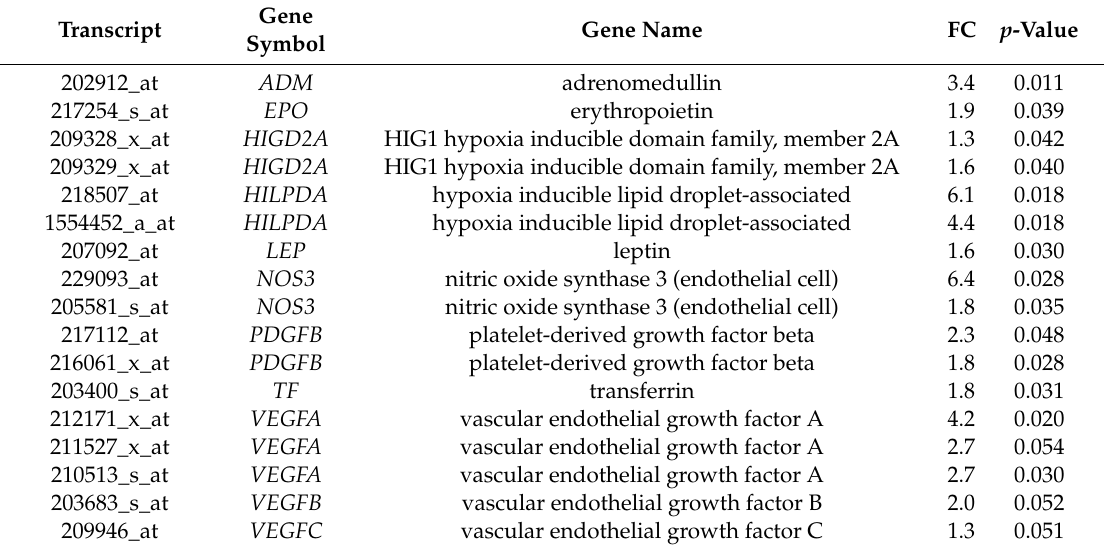
Table 1. Expression of hypoxia-induced transcripts